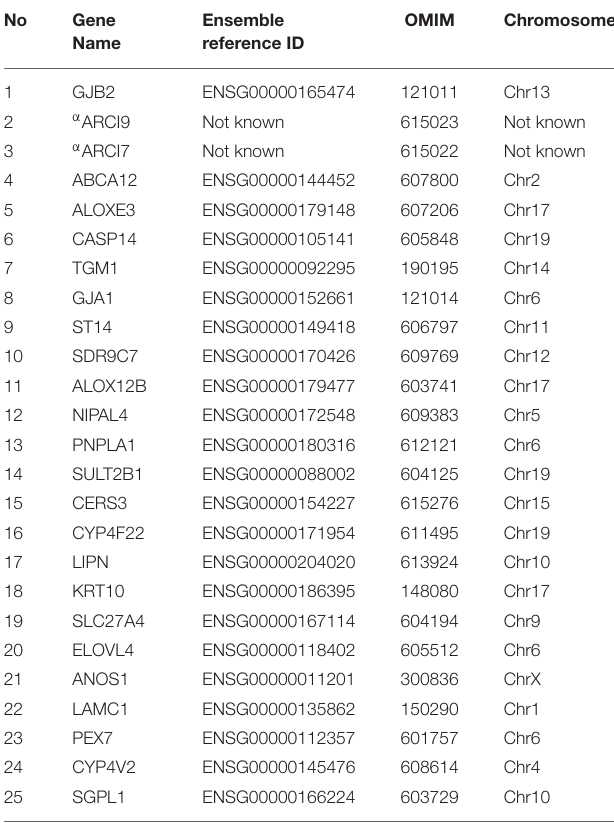
TABLE 1 | List of candidate genes for autosomal recessive congenial